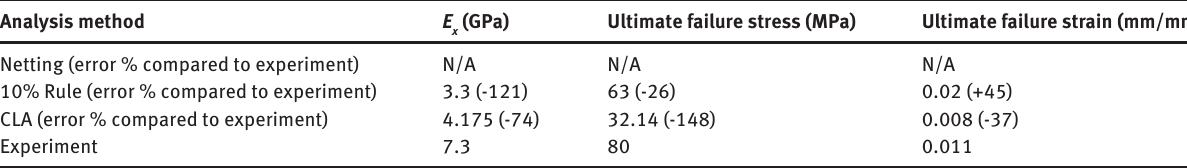
Table 3 Summary of [+67.5